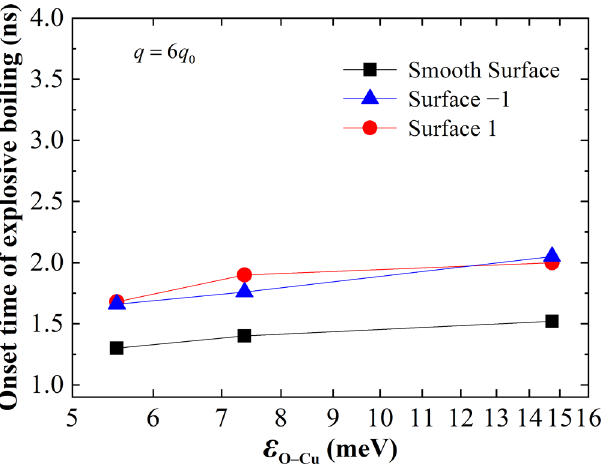
Figure 7. Comparison of the time of onset of explosive boiling at different wettability under a heat flux of 6 q 0